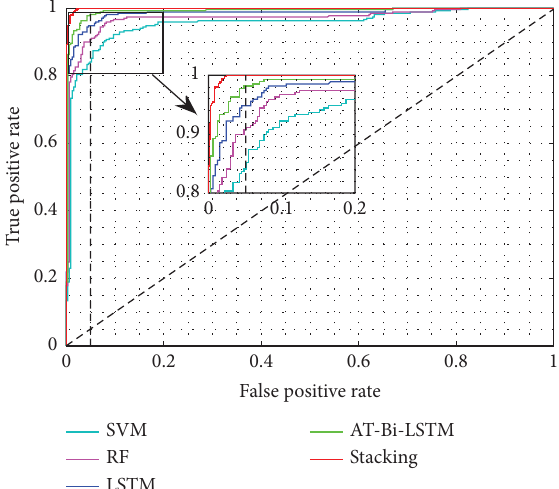
Figure 13: ROC curves of diferent models at 0s before crossing the zebra